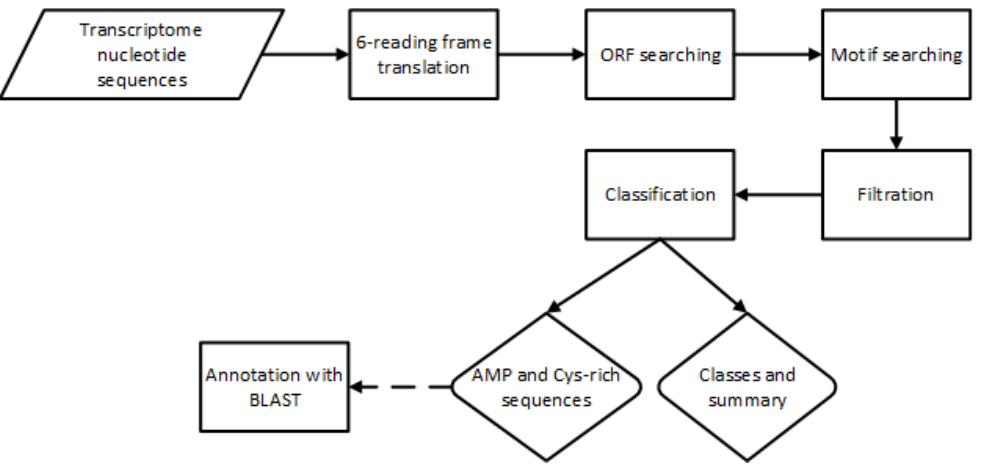
Figure 2. Flowchart of AMP identification process using a Cysmotif searcher pipeline.